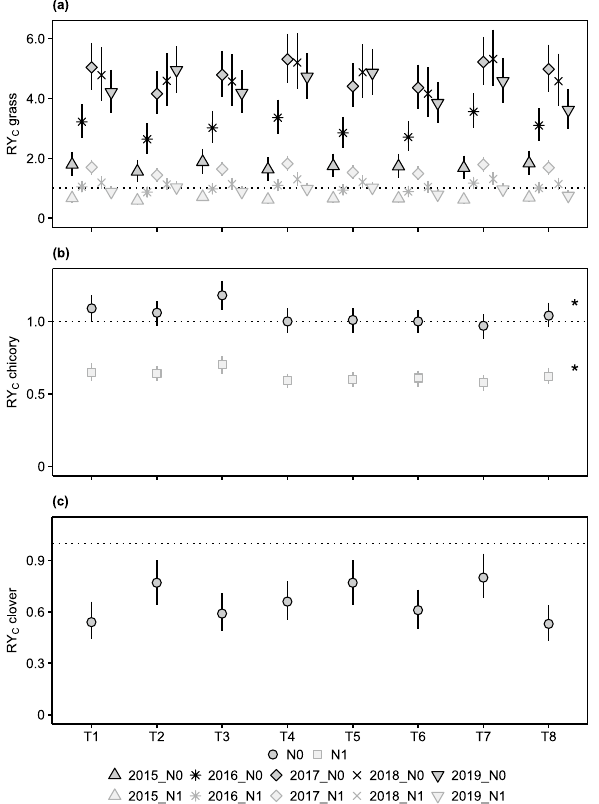
Figure 3. Corrected relative yields (RY C ) of ( a ) grass, ( b ) chicory and ( c ) clover for different white clover populations (T1–T8) using either unfertilized (N0) or fertilized (N1) non-leguminous pure stands as a reference. For grass RY C , the population × year interaction is shown ( n = 16). Otherwise, the population main effect is presented (chicory RY C n = 80, clover RY C n = 120). Except for *, given values are model predictions with 95% confidence intervals. Asterisks (*) indicate that arithmetic means with standard errors are shown, as the minimum adequate model did not include the effect of population. Note that scales of the y-axis differ between panels. Pure stand and mixture yield of the white clover populations can be found in Supplementary Table